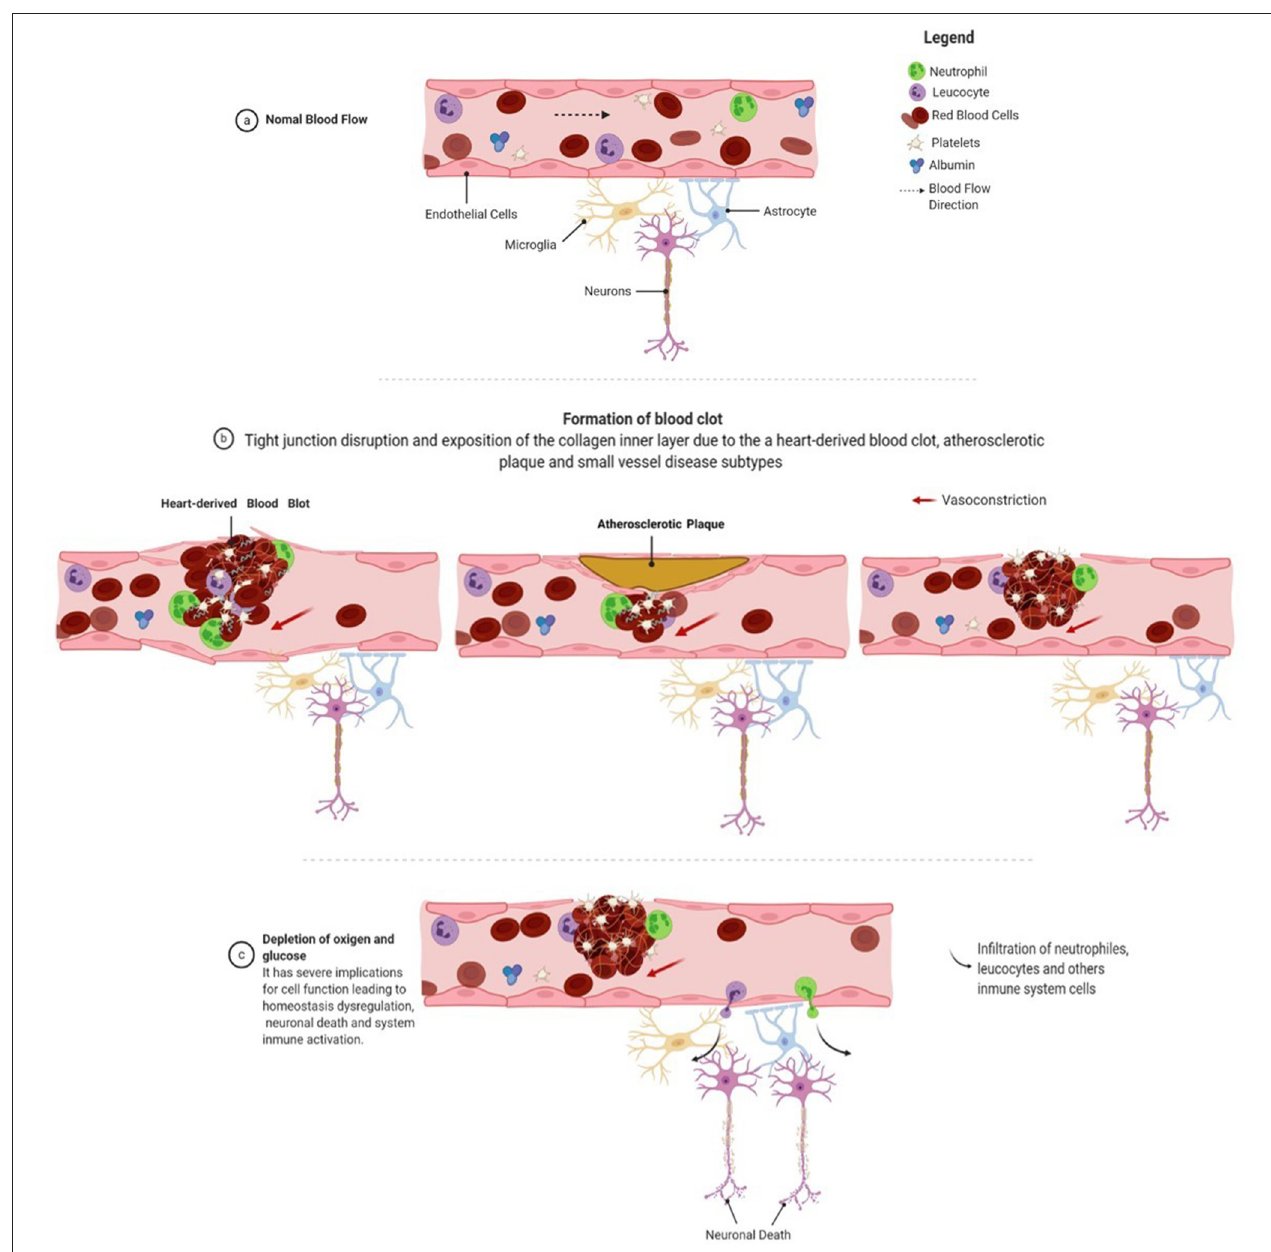
FIGURE 2 | Stroke pathophysiology. The clot formation process starts with disrupting the blood–brain barrier due to a rupture of the endothelial cell layer, exposing the blood vessel’s inner collagen layer. Collagen exposure is recognized by circulating platelets in the bloodstream, which initiates the process of aggregation. Fibrinogen is released from the liver to the bloodstream and is cleaved by thrombin at the damaged site, resulting in fibrin formation. Fibrin is one of the main constituents of blood clots, providing remarkable biochemical and mechanical stability. The blood clot is also composed of neutrophils and leukocytes that arrive at the injured site and form a solid structure that obstructs or reduces blood flow. The reduction in blood flow leads to a decrease in oxygen and glucose levels. These conditions favor a shift in the neuron’s metabolic conditions, mitochondrial dysfunction, excitotoxicity, ion imbalance, and neuronal death. Figure was drawn using Biorender.com.